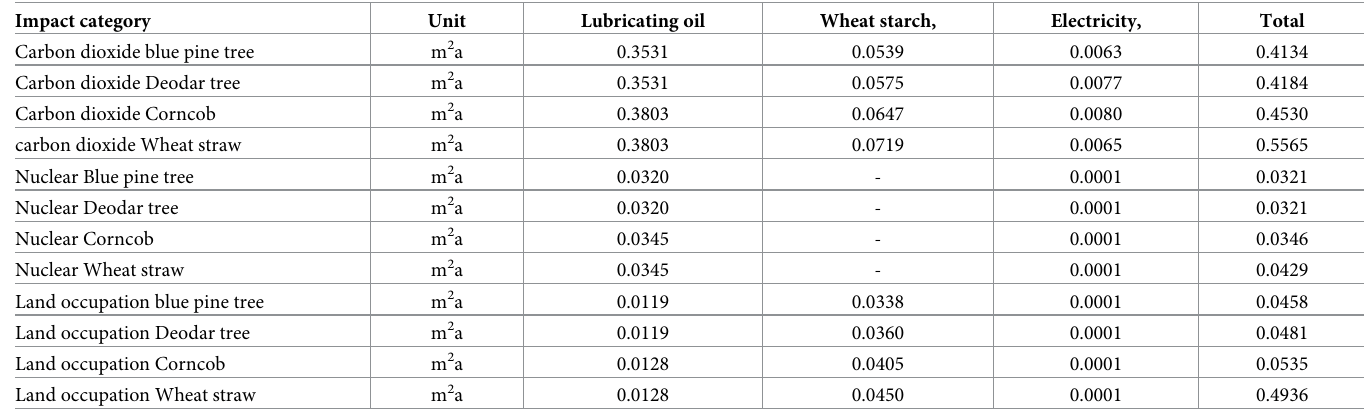
Table 6. Ecological footprint of biomass pellets biofuel from Agro-forestry species